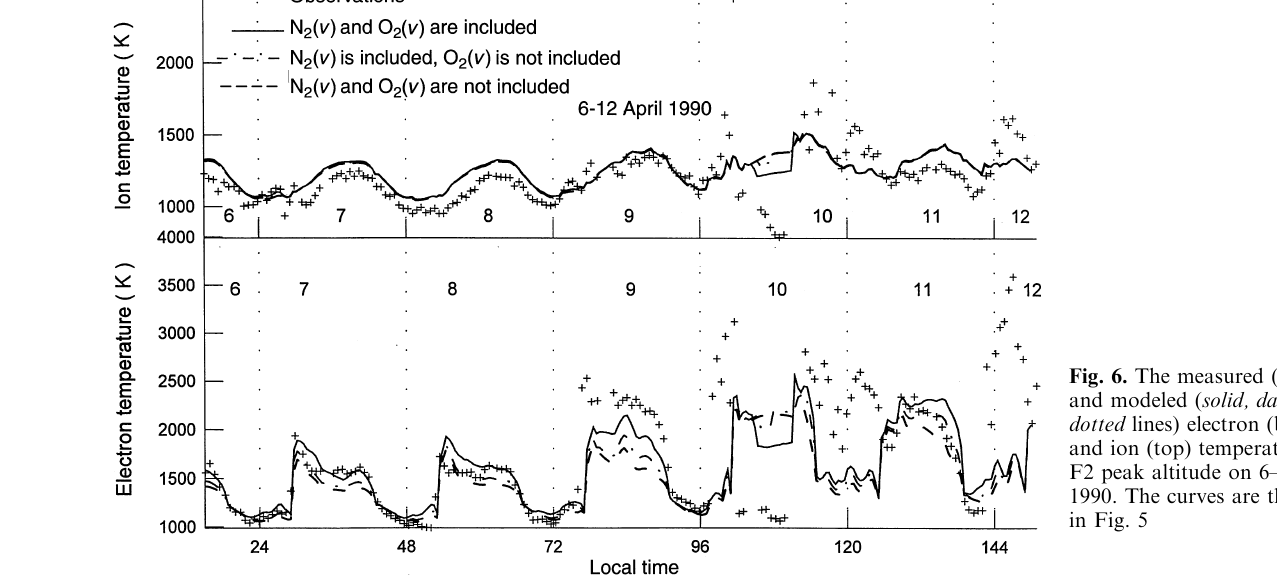
Fig. 6. The measured ( crosses ) and modeled ( solid, dashed and dotted lines) electron (bottom) and ion (top) temperatures at the F2 peak altitude on 6–12 April 1990. The curves are the same as in